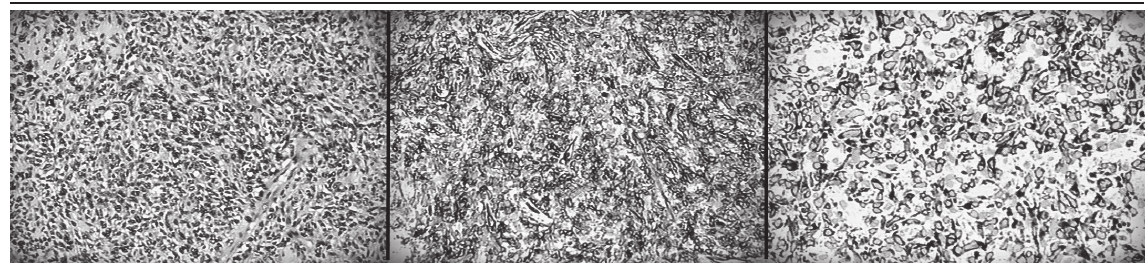
figurE 4 – Microscopic appearance On the left, hematoxylin-eosin stain, showing mesenchymal proliferation with spindle cells associated to collagen deposition. On the right and in the middle, immunohistochemistry for CD34 and bcl-2, respectively, showing strong and diffuse reactivity. Original magnification